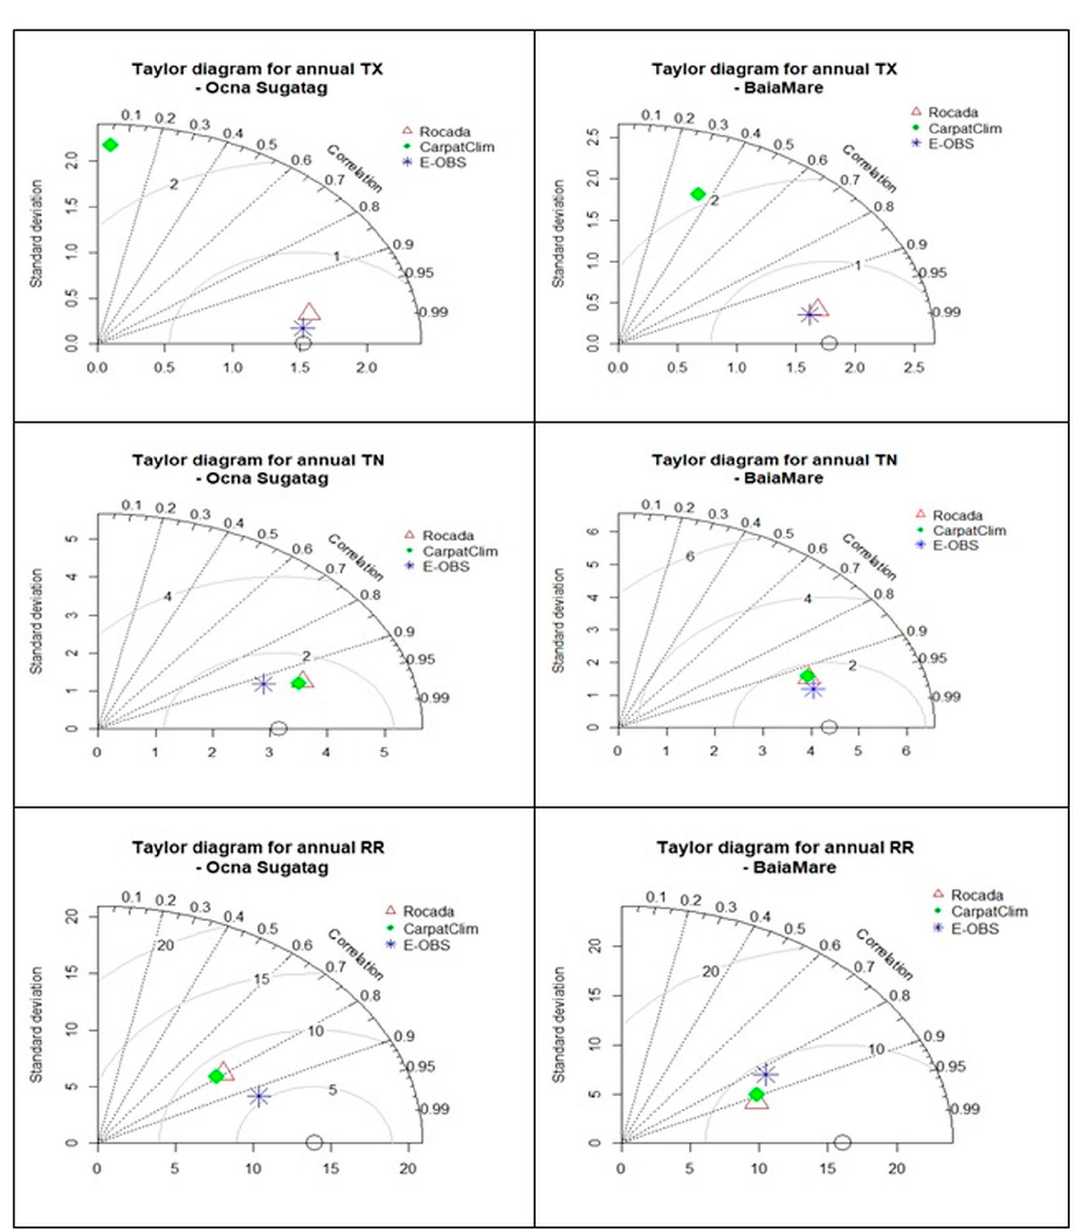
Figure 7. Taylor diagrams for the extreme annual values (TX, TN, and RR) over the period 1961–2010 at the Ocna Ș ugatag and Baia Mare weather stations.